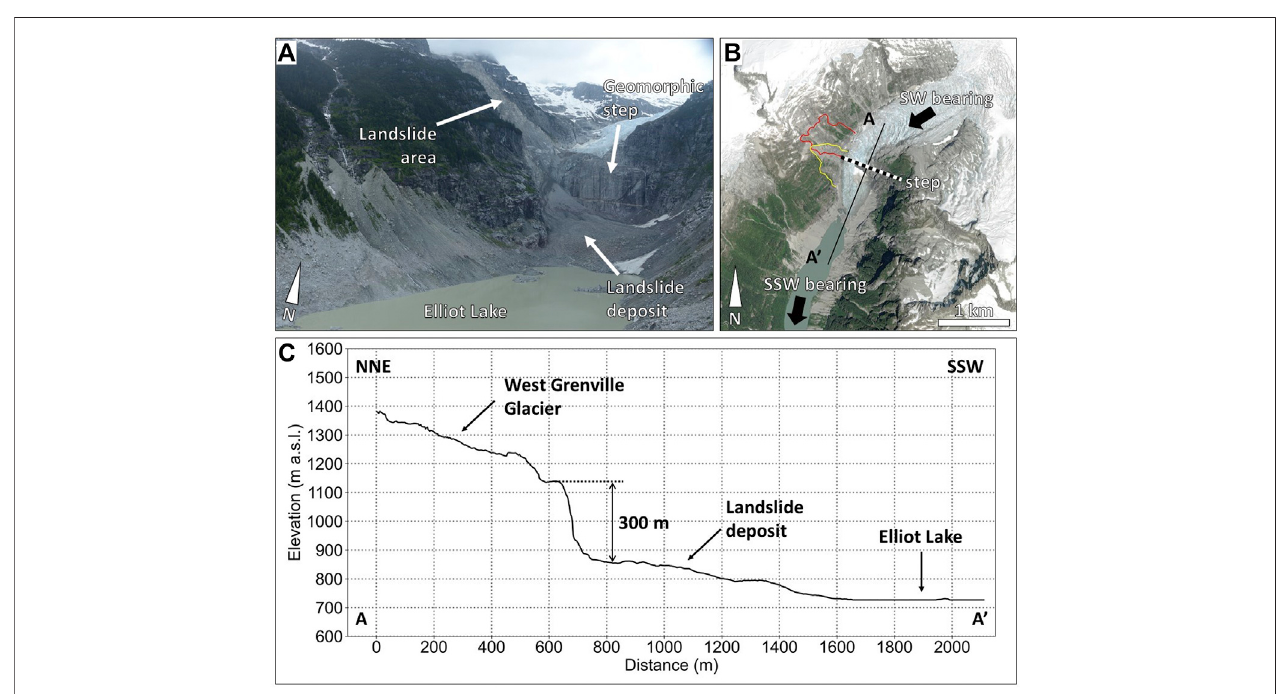
FIGURE 5 | Overview of the geomorphic con fi guration of the Elliot Creek near the landslide area. (A) oblique view of the Elliot Creek, looking north, showing the geomorphic step on which West Grenville Glacier is located (photo June 2021). (B) satellite view (ESRI World Imagery Map) of the landslide area prior to the failure. The varying trend of the Elliot Creek above and below the step is highlighted. The boundaries of the old and the 2020 landslides are marked by the yellow and red curve, respectively. The pro fi le along the A-A ′ segment is shown in (C) . (C) Pro fi le along A-A ′ in (B) . The geomorphic step roughly occurs at the interface between the rupture surfaces of the old and 2020